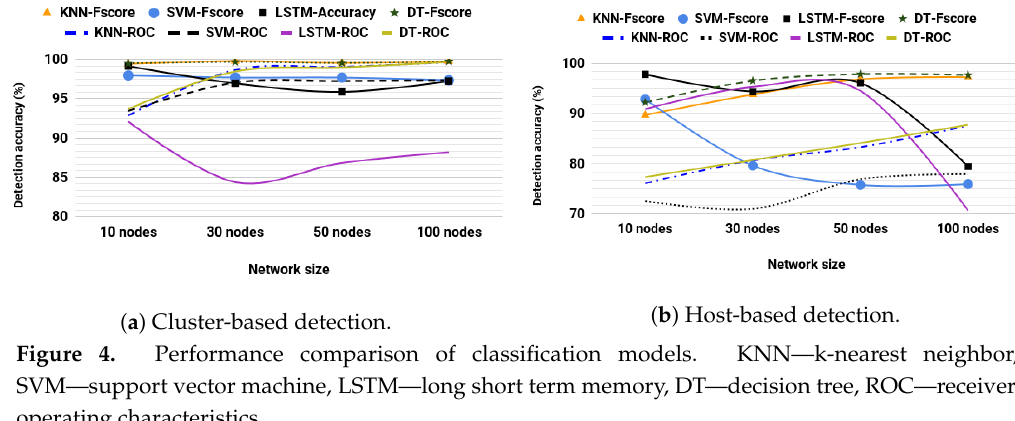
Figure 4. Performance comparison of classification models. KNN—k-nearest neighbor,